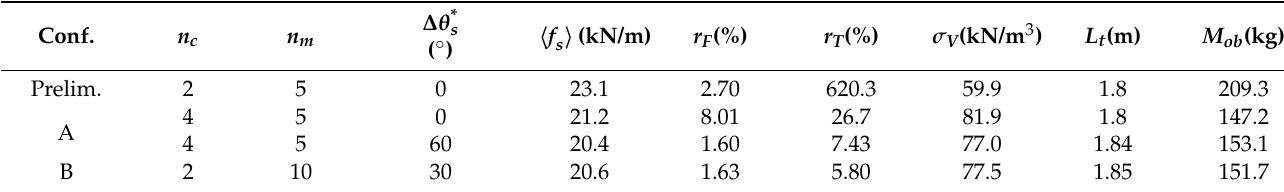
Table 4. Comparison between different RPMC arrangements.